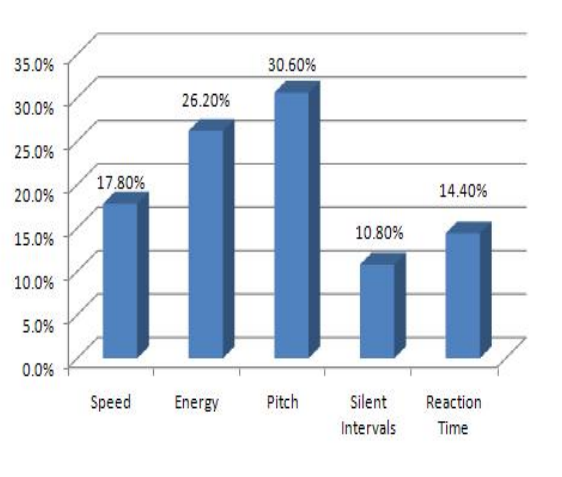
Fig. 7. Classification accuracy of each feature set by hu- man.(Source: findings from the experiments of this